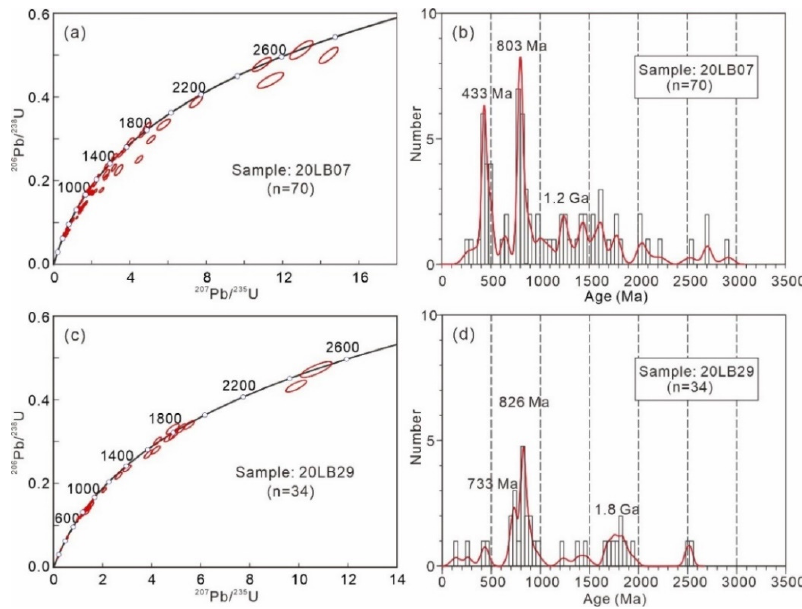
Figure 6. ( a , c ) Detrital zircon U–Pb concordia diagrams of the Middle Devonian Liba Group slate samples. ( b , d ) Detrital zircon probability density distribution curves of the Middle Devonian Liba Group slate samples.